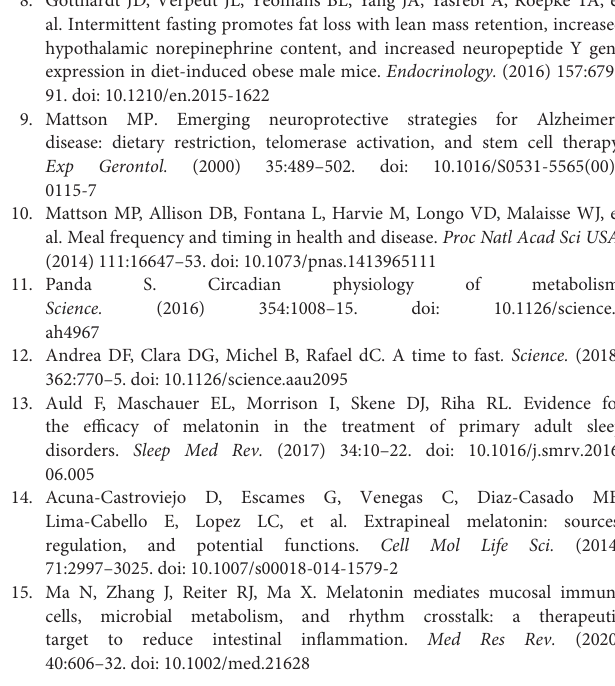
underwent alternative-day feed deprivation. The M and MF groups mice were supplemented with melatonin at a dose of 10 mg/kg body weight by drinking. Supplementary Figure 3 | The effects of intermittent fasting and melatonin supplementation on intestinal microbiota of mice. (A) The observed species index of gut microbiota in mice. (B) The Chao 1 index of gut microbiota in mice. (C) Barplot of intestinal bacterial content at the phylum level in each group; (D) relative abundance of Firmicutes in the intestinal contents of each group; (E) relative abundance of Bacteroides in the intestinal contents of each group; (F) the proportion of Firmicutes to Bacteroides . Data are presented as mean ± SEM, n = 12; Labeled means without a common letter differ ( P < 0.05), NS: P ≥ 0.05. C, control; F, intermittent fasting; M, melatonin; MF, intermittent fasting plus melatonin. The C and M mice were fed ad libitum , while the F and MF groups underwent alternative-day feed deprivation. The M and MF groups mice were supplemented with melatonin at a dose of 10 mg/kg body weight by drinking. Supplementary Figure 4 | Significantly altered intestinal metabolites between in control mice and those treated with intermittent fasting and melatonin. The contents of glucose (A) , ribose (B) , alanine (C) , glycine (D) , valine (E) , isoleucine (F) , tyrosine (G) , and 2-ketoadipate (H) in each group are shown. Data are presented as mean ± SEM, n = 12; Labeled means without a common letter differ ( P < 0.05), NS: P ≥ 0.05. C, control; F, intermittent fasting; M, melatonin; MF, intermittent fasting plus melatonin. The C and M mice were fed ad libitum , while the F and MF groups underwent alternative-day feed deprivation. The M and MF groups mice were supplemented with melatonin at a dose of 10 mg/kg body weight by drinking. Supplementary Figure 5 | Correlations between the phenotype and the differences of bacteria (genus) or metabolites in the intestine. (A) Correlations between the phenotype and the differences of bacteria (genus) and metabolites. (B) Correlations between bacteria (genus) and metabolites in the intestine. Supplementary Table 1 | All the metabolites detected in the intestinal contents in mice. C, control; F, intermittent fasting; M, melatonin; MF, intermittent fasting plus melatonin. The C and M mice were fed ad libitum , while the F and MF groups underwent alternative-day feed deprivation. The M and MF groups mice were supplemented with melatonin at a dose of 10 mg/kg body weight by